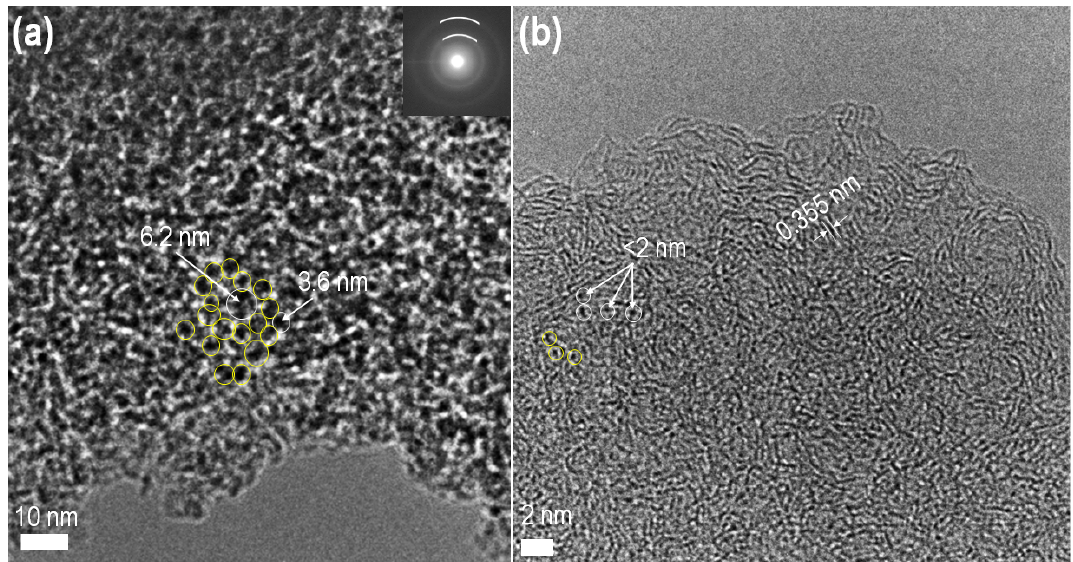
Figure 3. ( a ) Transmission electron microscope (TEM) image of LSC_1 as a typical example. ( b ) The corresponding high-resolution TEM (HR-TEM) image. Inset of panel ( a ) shows the selected area electron diffraction (SAED) pattern. Circles in panels ( a , b ) highlight mesopores and micropores, respectively.